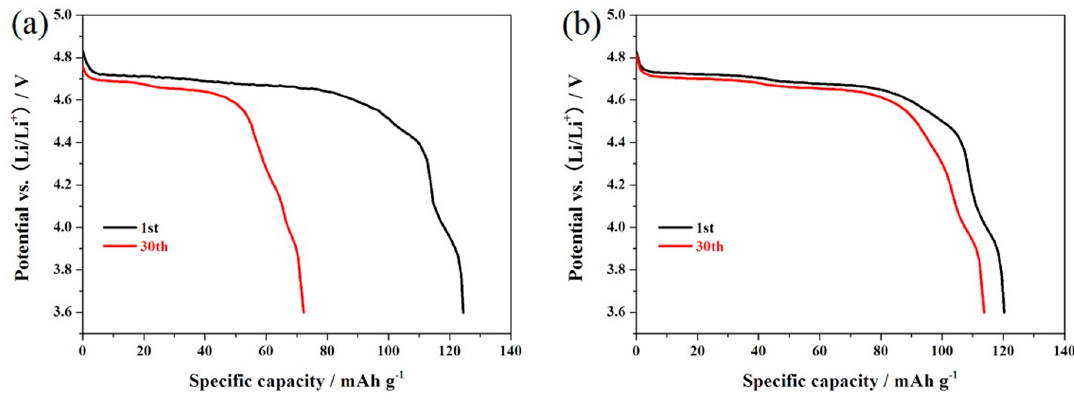
Figure 8. Representative discharge curves of the LiNi 0.5 Mn 1.5 O 4 ( a ) and Er-doped LiNi 0.5 Mn 1.5 O 4 ( b ) at 55 ◦ C.